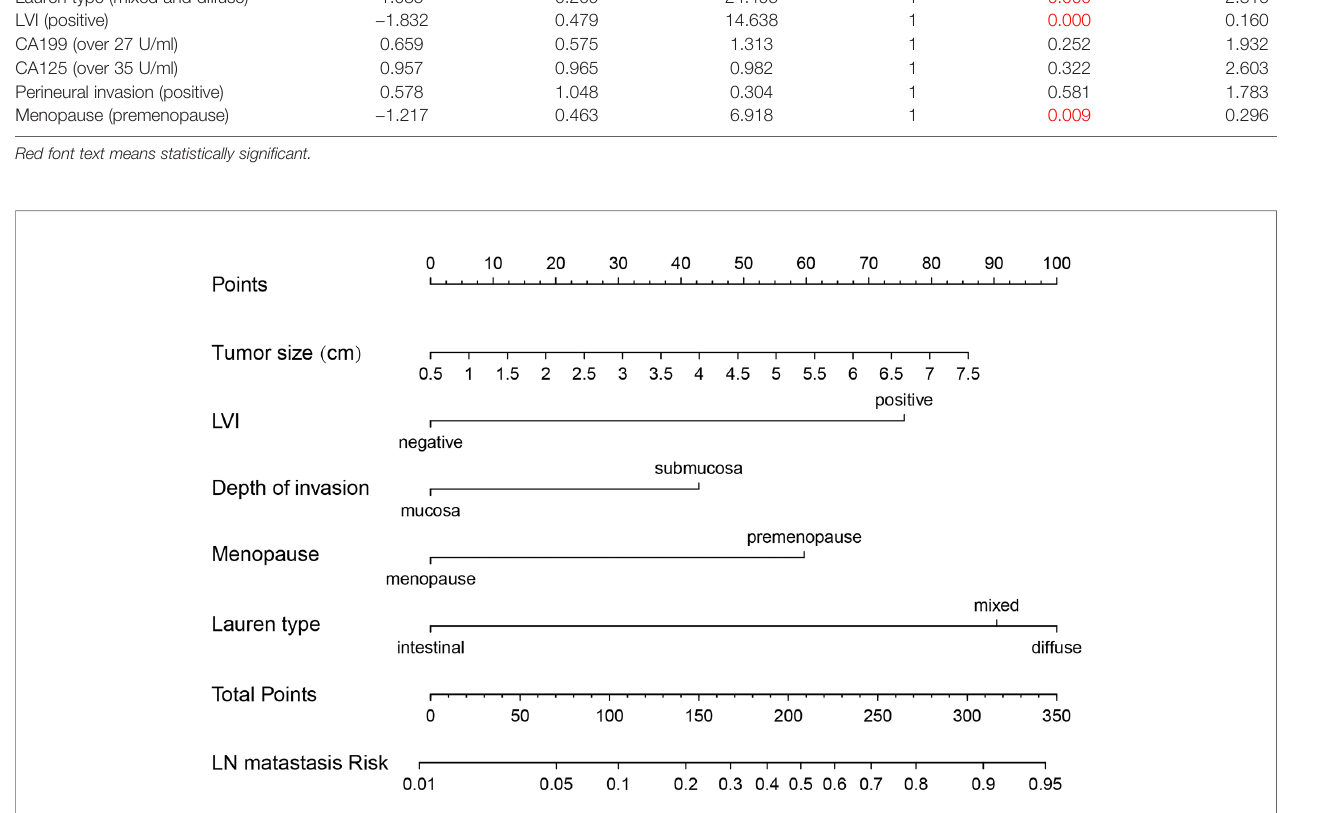
FIGURE 2 | Nomogram prediction model for LN metastasis in female EGC patients. LN, lymph node; LVI, lymphovascular invasion; EGC, early gastric